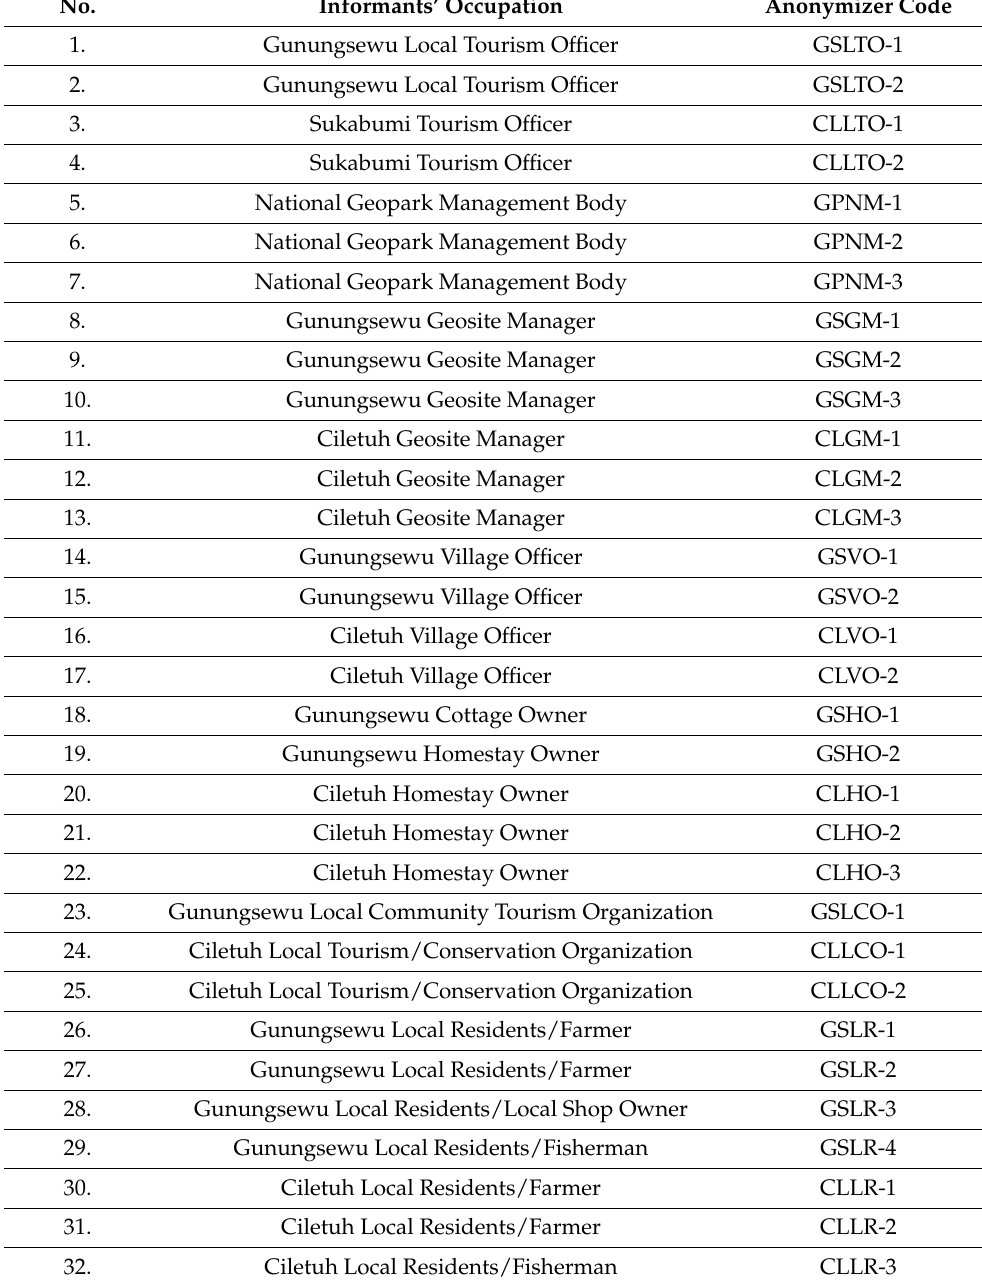
Table 1. List of Informants with Occupation and Anonymizer